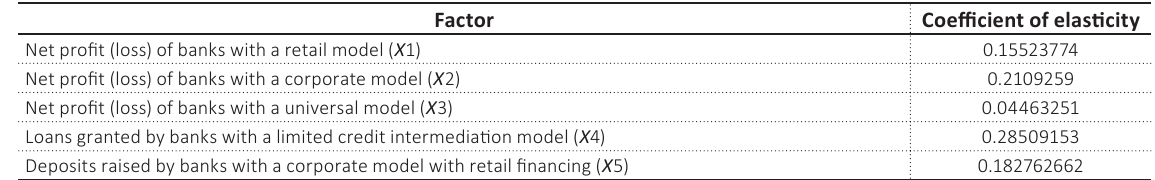
Table 3. Elasticity coefficients of changes in the absolute value of 1% real GDP growth to changes in factors of the regression model